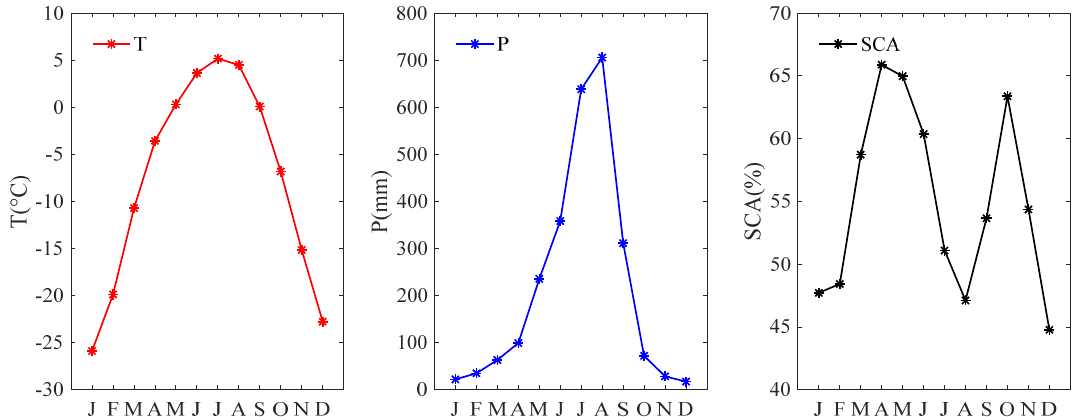
Figure 2. The watershed-averaged temperature (T), precipitation (P) and snow-covered area (SCA) (Period 2003–2012). The T, P and SCA were derived from the Hotan station, China Ground Rainfall Daily Value 0.5° × 0.5° Lattice Dataset and MODIS product, respectively.